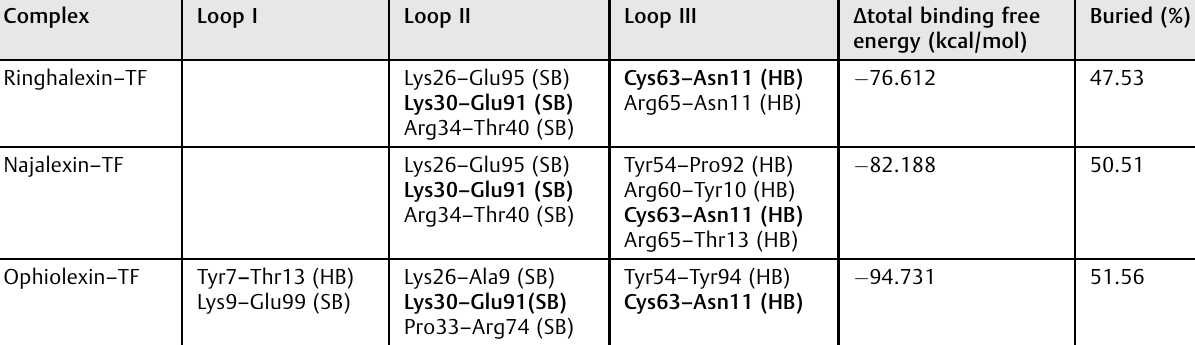
Table 2 Residues of ringhalexin, najalexin, ophiolexin, and TF (tissue factor) involved in interactions based on protein – protein docking